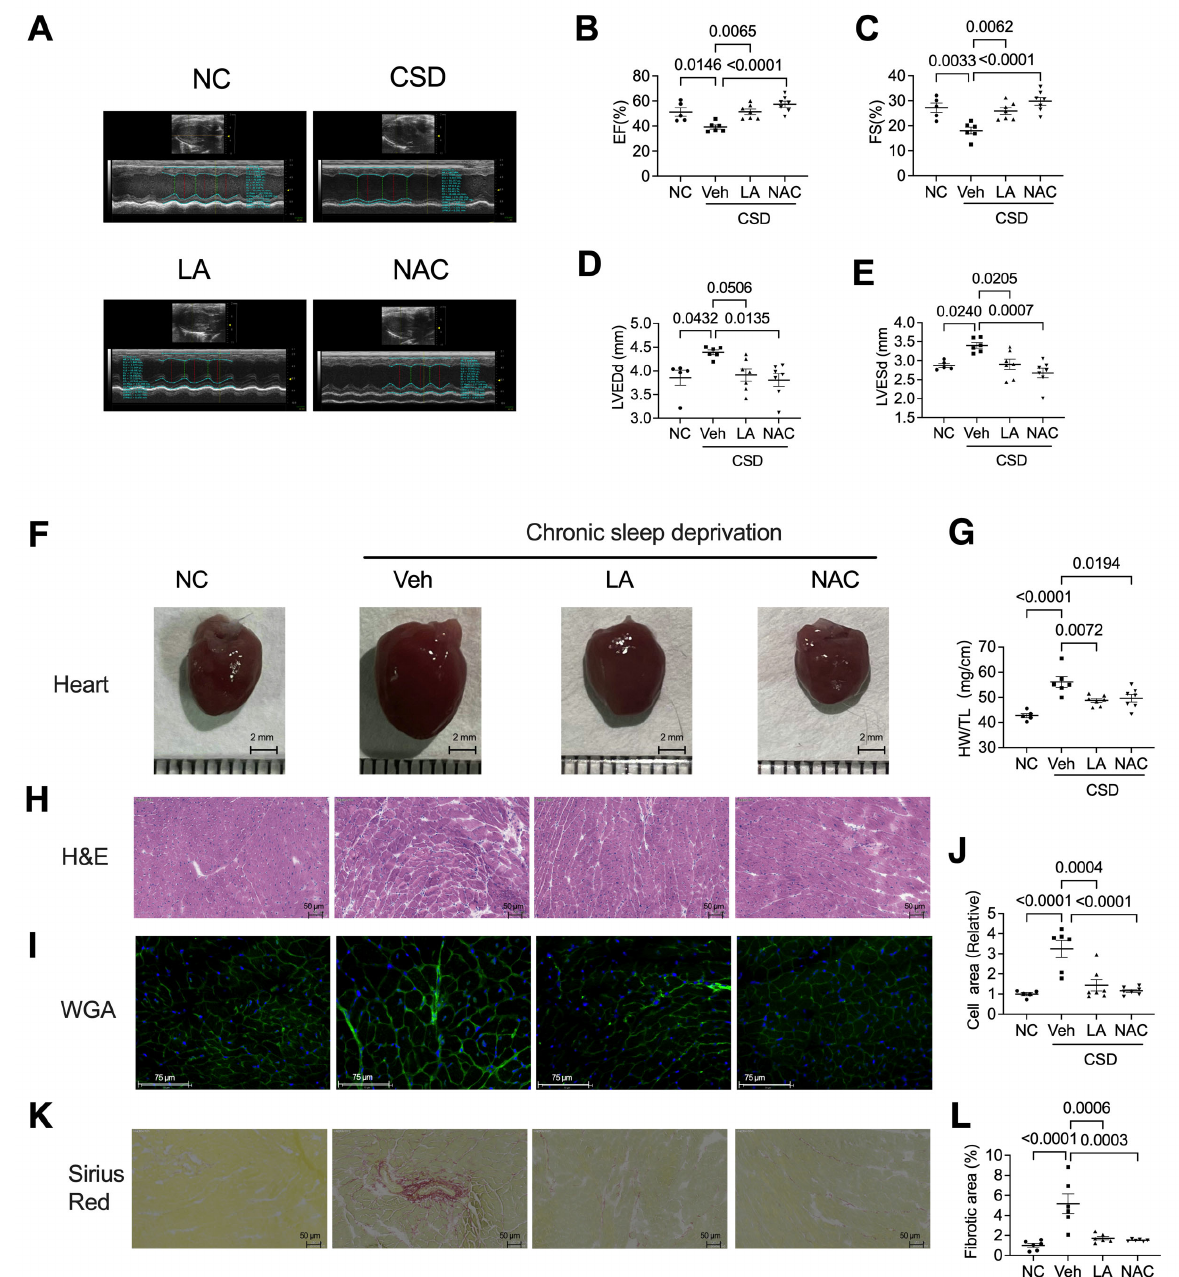
Figure 4. Antioxidants significantly rescue CSD ‐ induced heart failure and myocardial hypertrophy. Representative echocardiography ( A ) and quantification of EF ( B ), FS ( C ), LVEDd ( D ), and LVESd ( E ) of the four indicating groups. ( F ) Representative anatomic images of four indicating groups (scale bar = 1 mm). ( G ) The ratio of heart weight (HW) to tibia length (heart/tibia) of four indicated groups. ( H ) Hematoxylin & eosin (HE) images of crosscut section heart of four displaying groups. Representative image ( I ) and quantification ( J ) of immunostaining of WGA indicating the cardiomyocyte size of four indicating groups (scale bar = 75 μ m). Representative images ( K ) and analyzed data ( L ) of Sirius red ‐ stained hearts of four indicating groups (scale bar = 50 μ m).